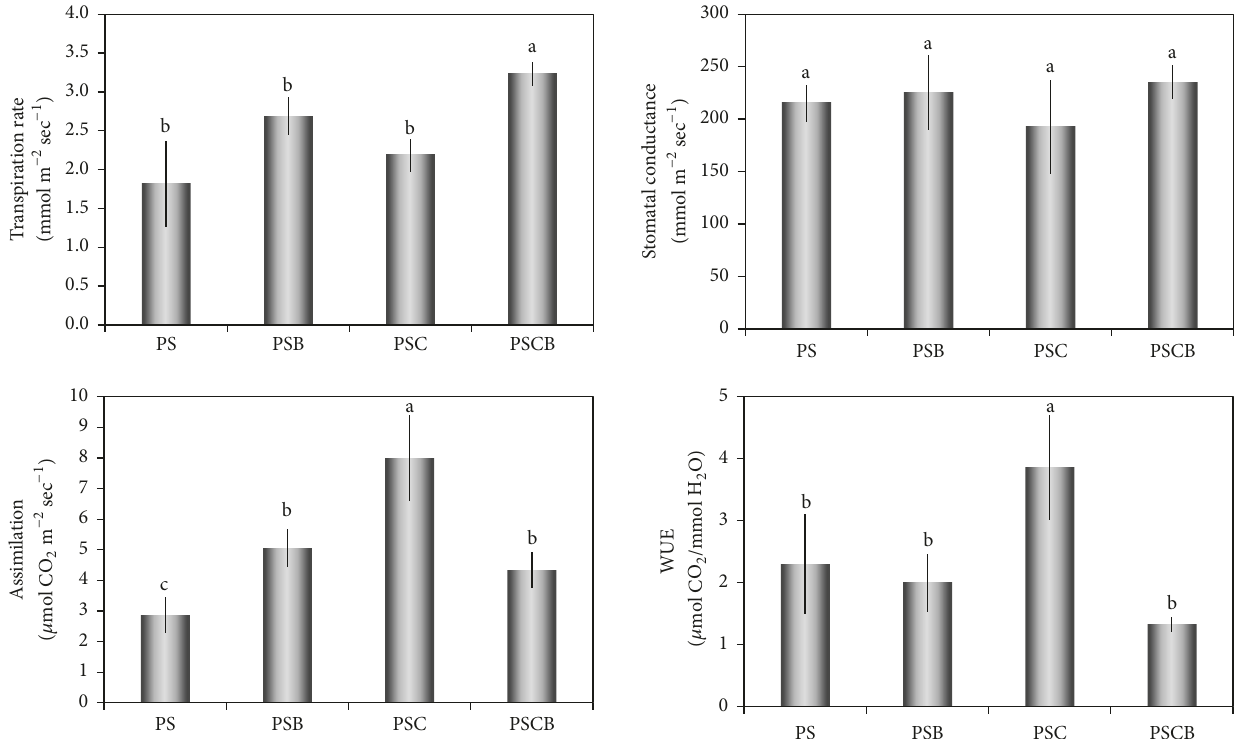
Figure 5: Transpiration rate, stomatal conductance, assimilation, and water use efficiency (WUE) of plants grown in different soils . Values are means ( 𝑛 = 5 ) ± standard error; significant differences between the means (at least 𝑝 ≤ 0.05 , according to ANOVA) appear with different letters. PS = lettuce plants grown in unfertilized soil; PSB = lettuce plants grown in unfertilized soil plus biochar; PSC = lettuce plants grown in unfertilized soil plus compost; and PSCB = lettuce plants grown in unfertilized soil plus compost and